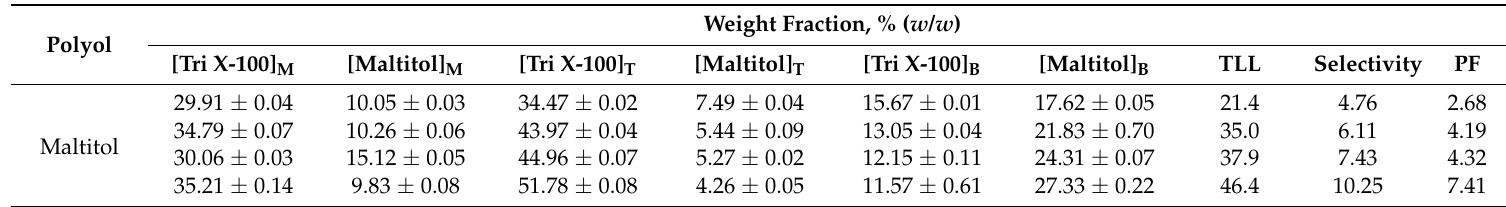
Table 2. Weight fraction composition for the TLs and their respective TLLs, at the top (T) and bottom phase (B), and initial biphasic composition of the mixture